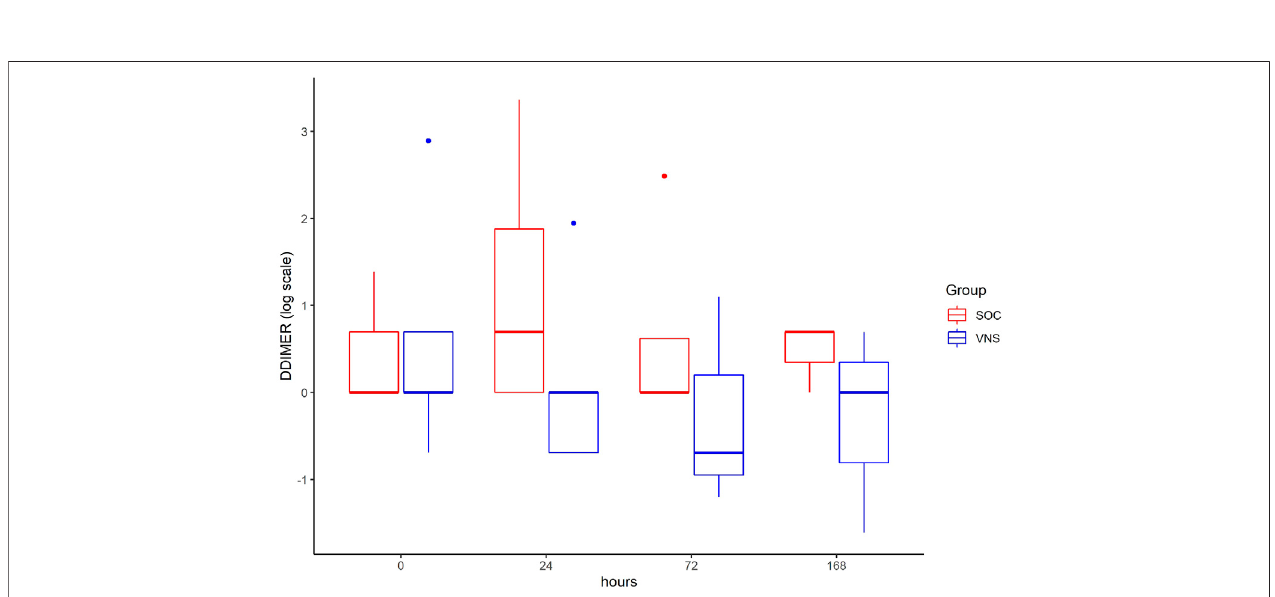
FIGURE 10 | Median DDIMER level with Interquartile Range of patients receiving auricular Vagus Stimulation (VNS = blue) and patients only receiving Standard of Care (SOC = red) after 0, 24, 72, and 168 h of study inclusion.